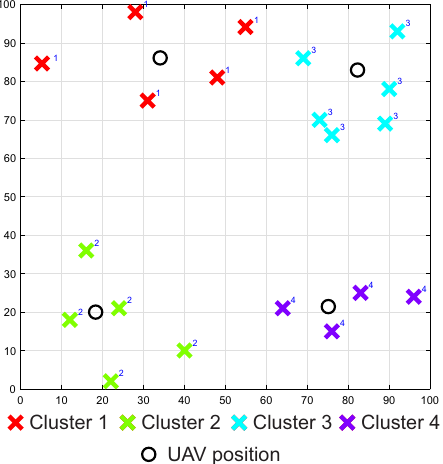
Figure 16. The example of the PSO clustering